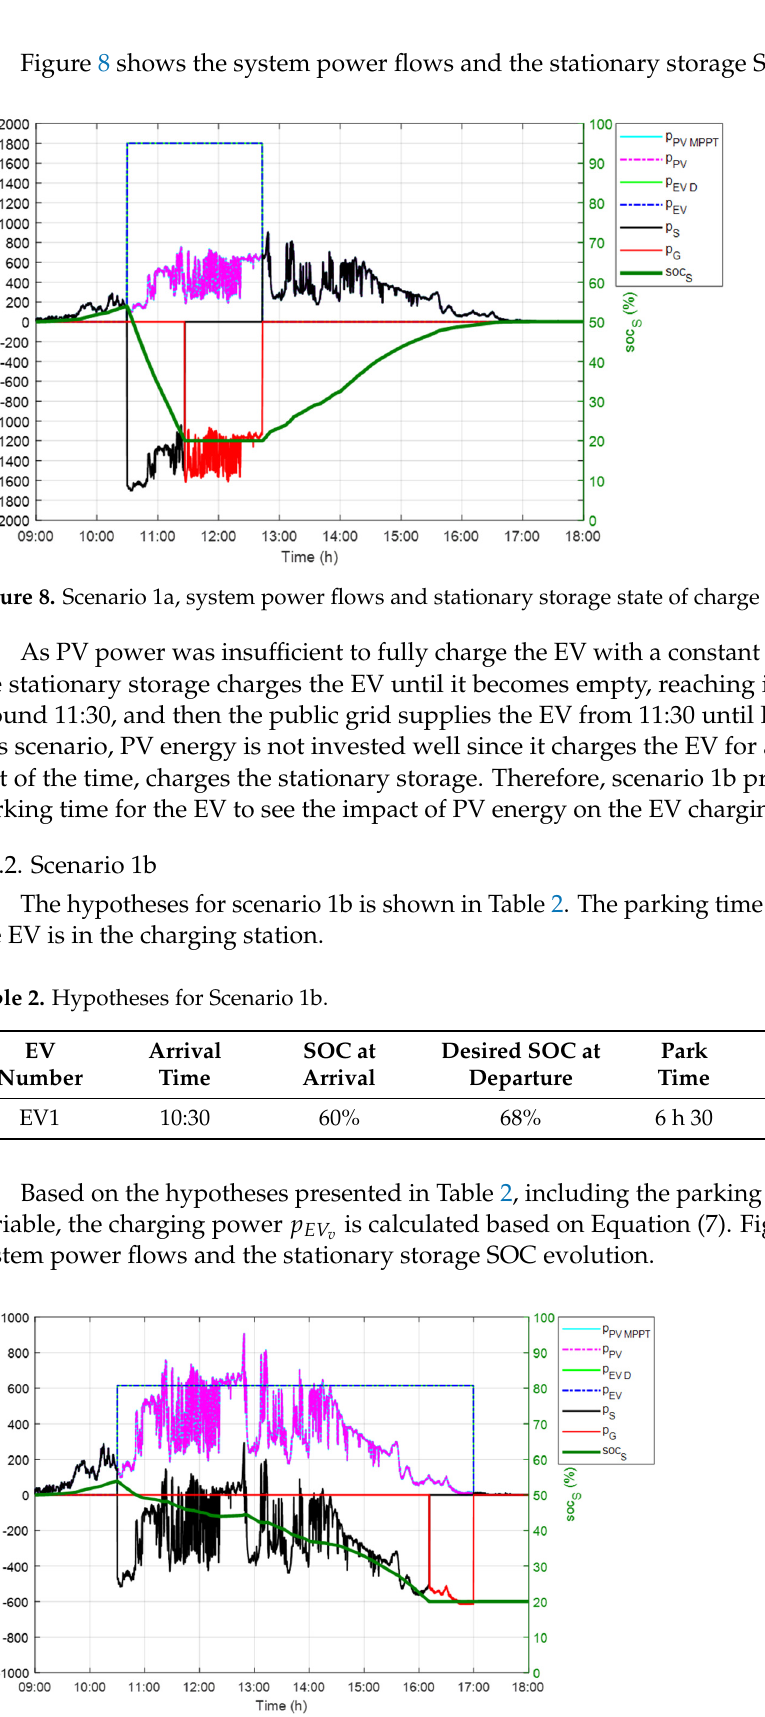
Table 1. Hypotheses for Scenario 1a.